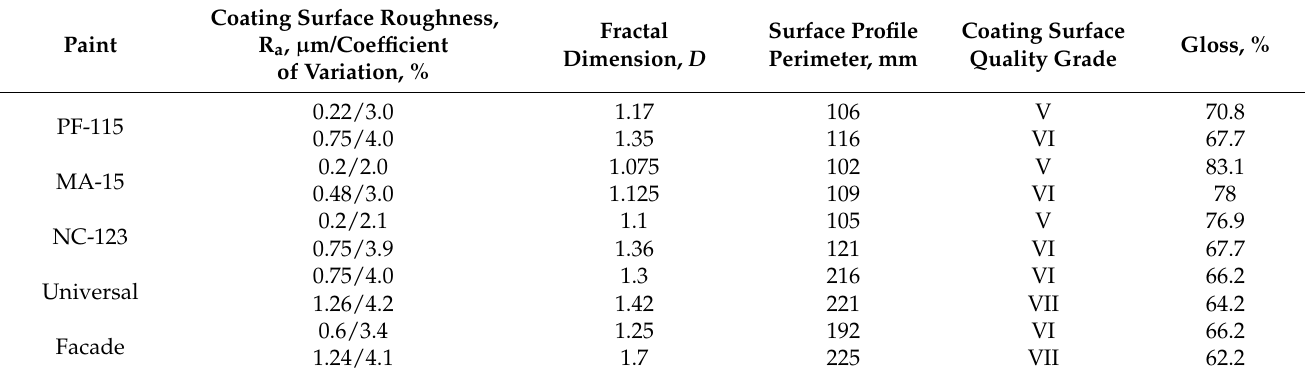
Table 2. Assessment of the quality of the appearance of the coating.